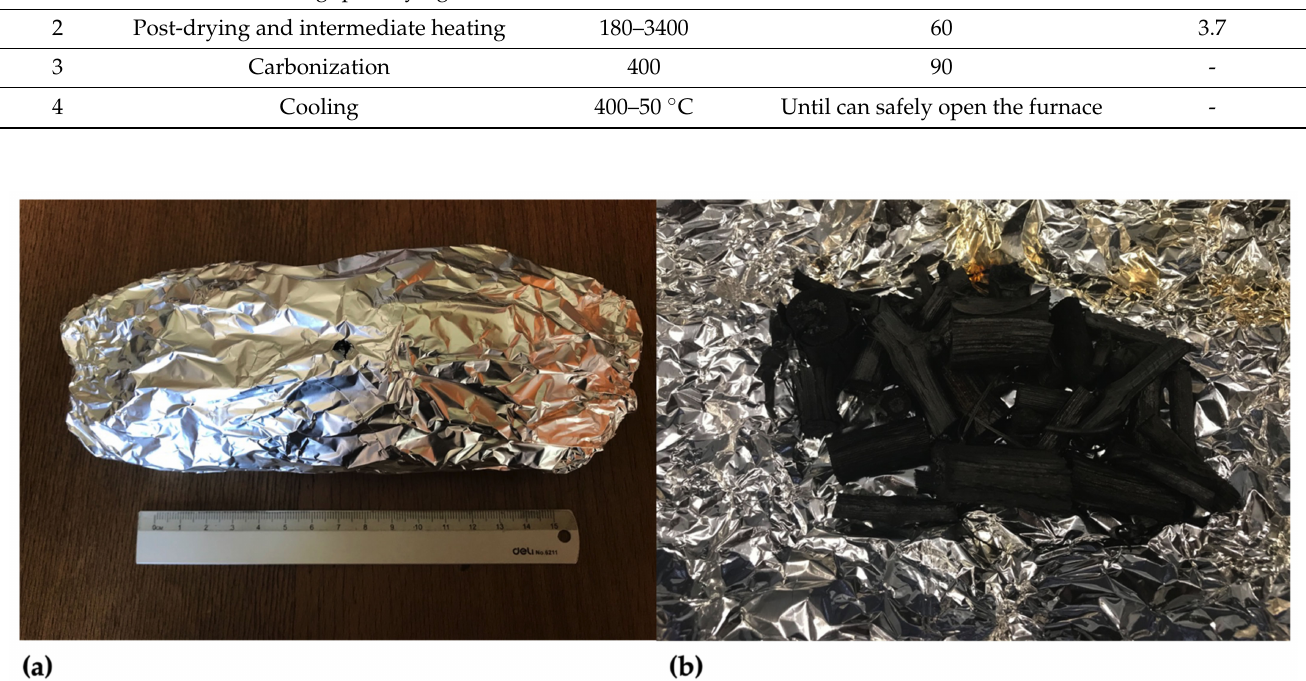
Figure 2. ( a ) Material wrapped in the aluminum foil; ( b ) produced